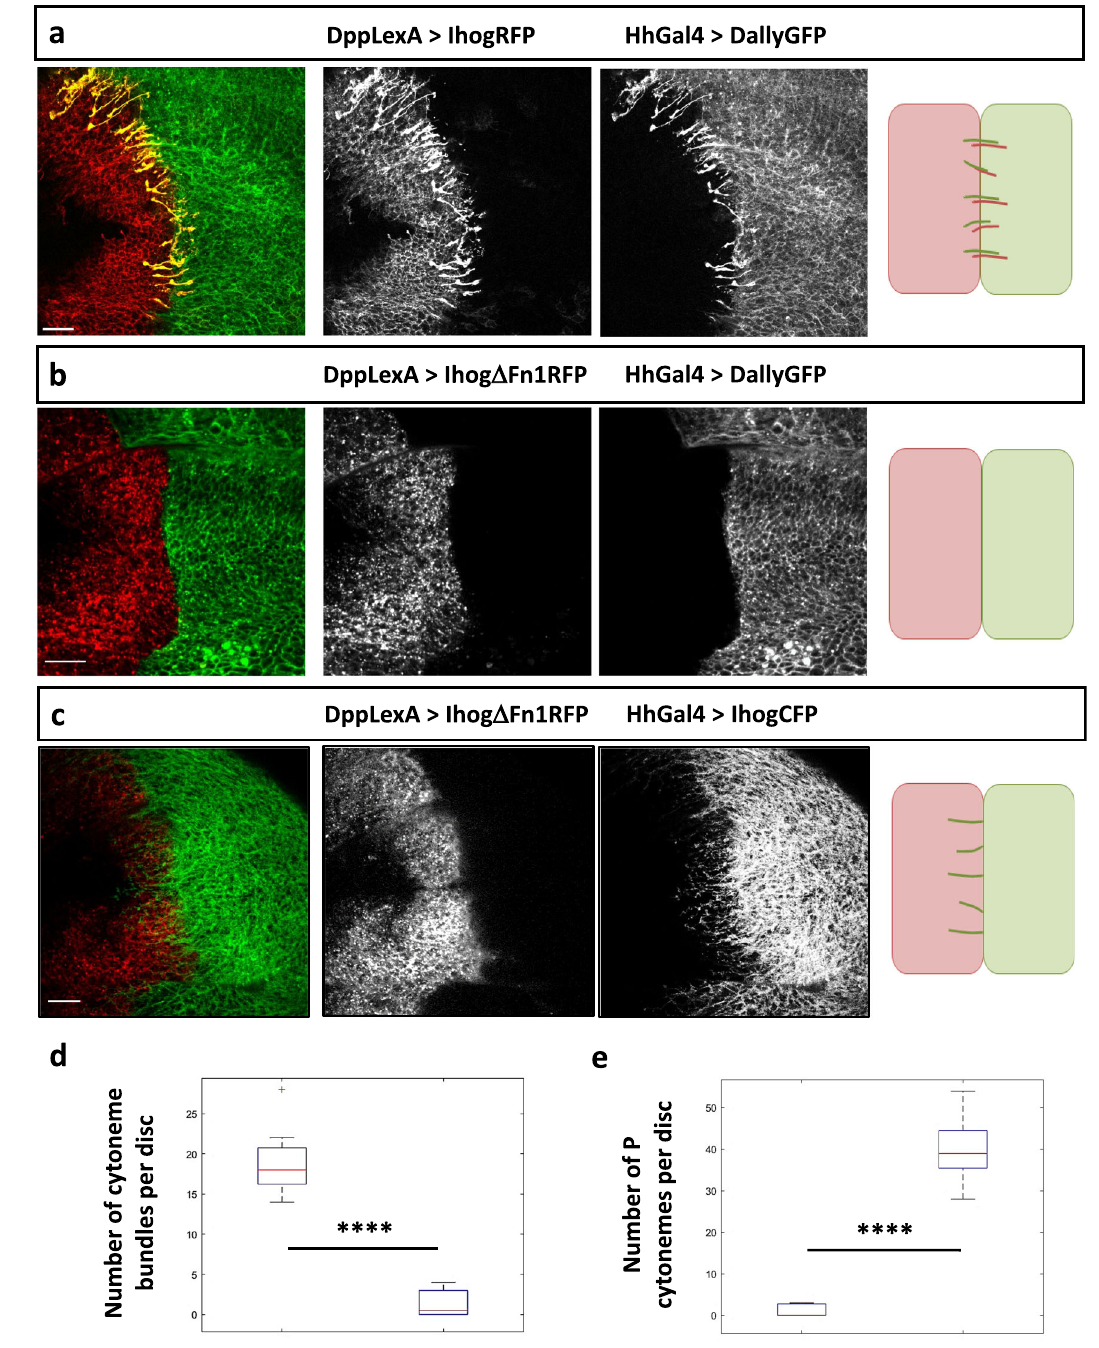
Fig. 4 | Ihog and glypicans interaction for cytoneme stabilization in trans is mediatedbytheFn1domainofIhog.a CytonemesprotrudingfrombothAandP compartments are strongly stabilized when cells overexpressing glypican Dally (green) are confronted to cells overexpressing wild-type Ihog (red). b Cytoneme bundle stabilization is lost when cells overexpressing Dally (green) are confronted to cells overexpressing the Ihog Δ Fn1 mutant form (red). The schemes at the right depict the cytoneme behavior in the different genetic conditions. c Cytonemes protruding from cells overexpressing wild-type Ihog (green) are stabilized when confrontedtocellsoverexpressingtheIhog Δ Fn1mutantform(red). d Boxplotand